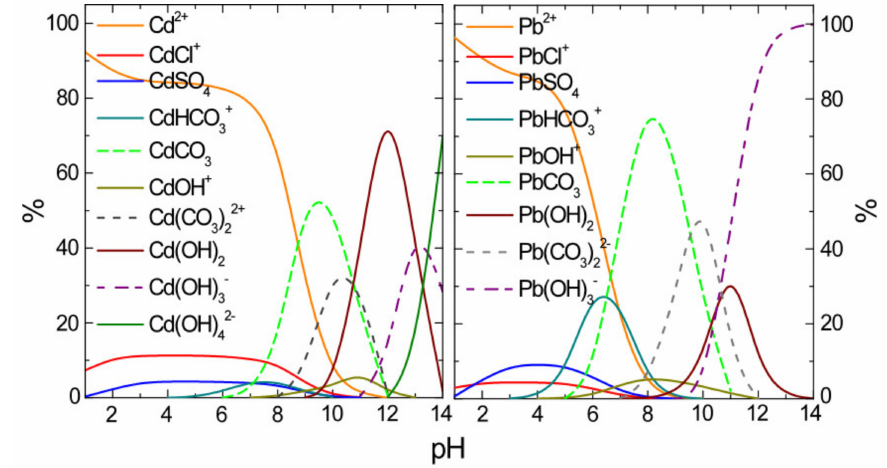
Figure 4. Speciation diagrams for the examined metals (Pb and Cd) at the initial concentration of 0.1 mg / L, according to the MINTEQ version 3.0 software in NSF water